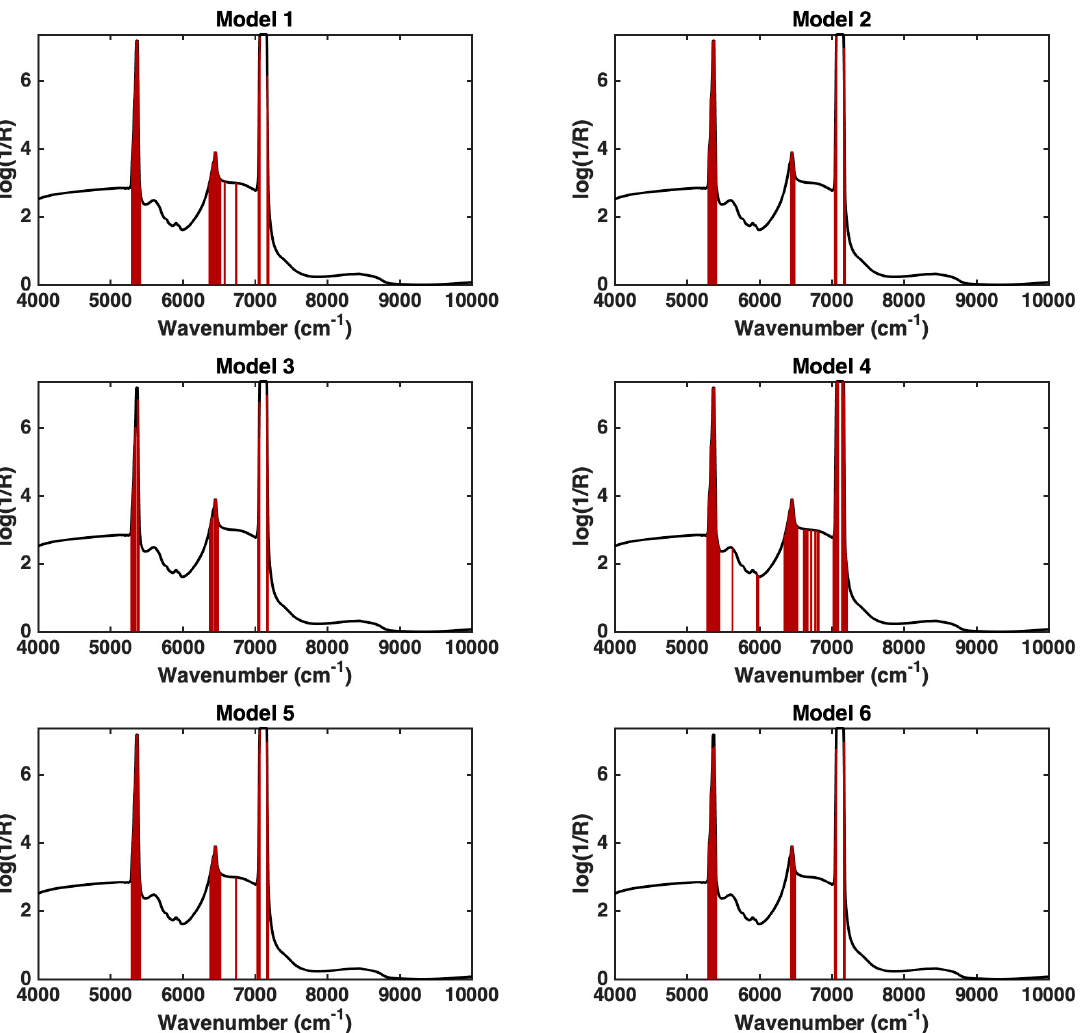
Figure 2. Variables identified as significantly contributing to the six calculated PLS-DA models according to the VIP analysis. For each model, the variables with VIP > 1 are highlighted as dark red bars over the mean spectrum of the training samples (black line).